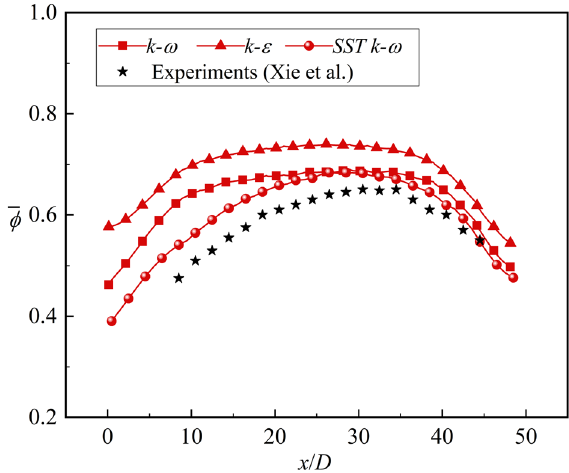
Figure 9. Validation of turbulence model.